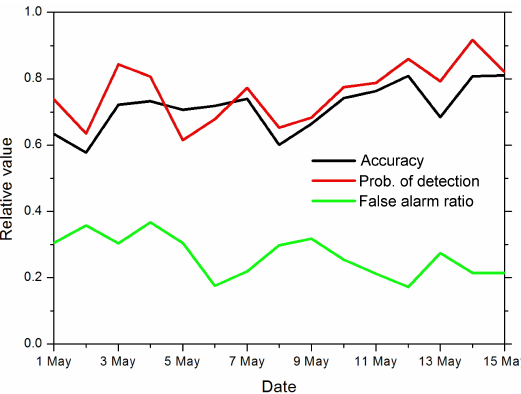
Figure 2. Time evolution of the forecast accuracy (black), the prob- ability of detection (hit rate, red) and the false alarm ratio (green) for the period 1–15 May